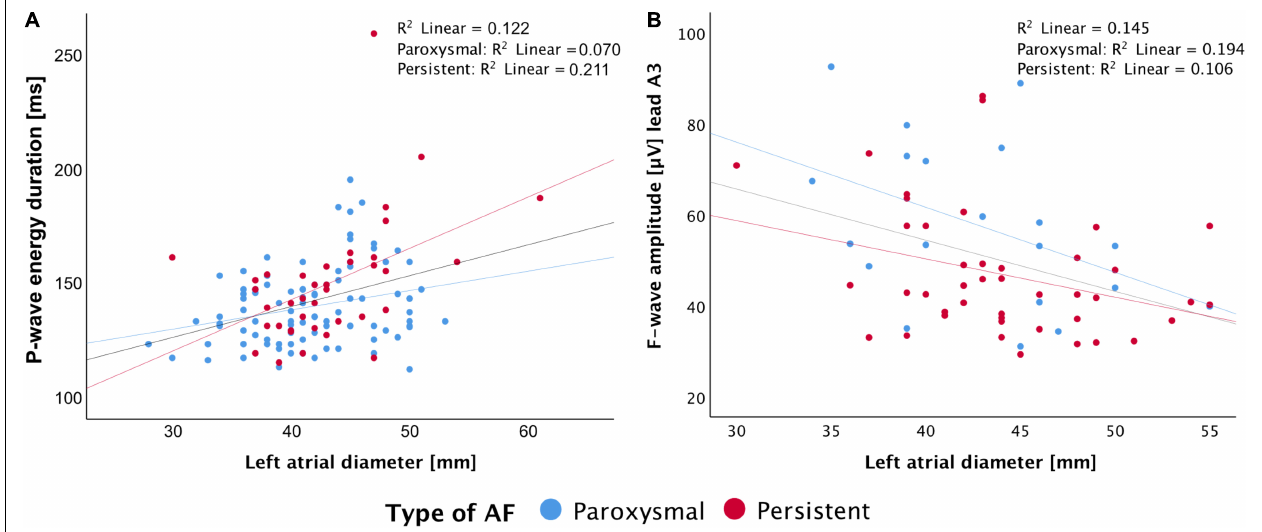
FIGURE 4 | Correlation of left atrial diameter with P-wave energy duration (A) and f-wave amplitude in lead A3 (B)